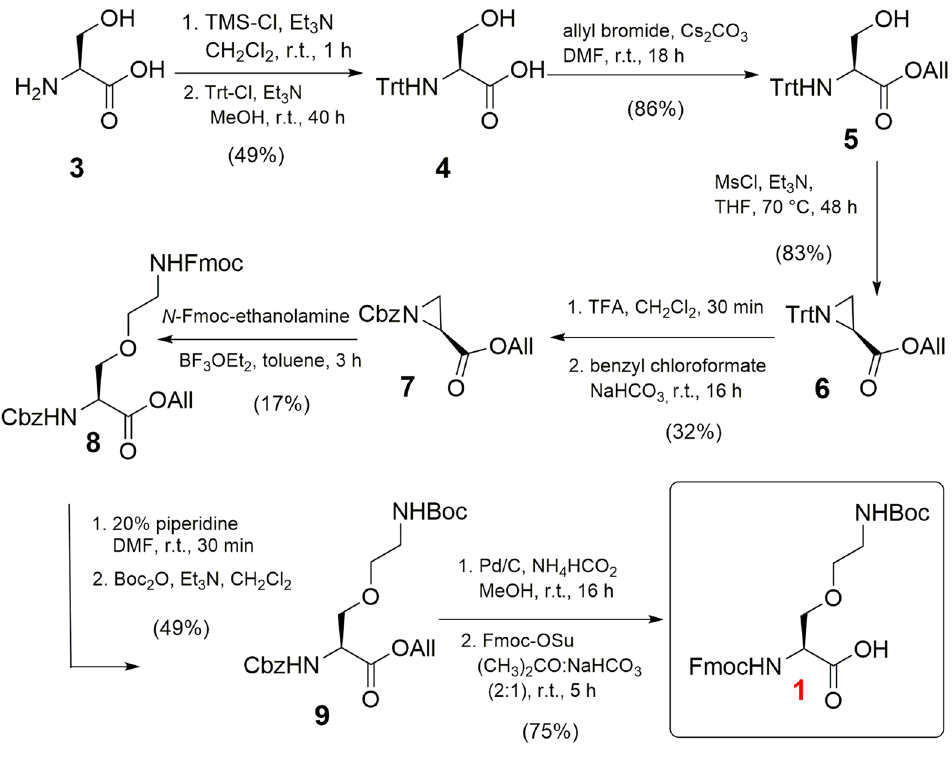
Figure 2. Synthesis of Fmoc-K O (Boc)-OH ( 1